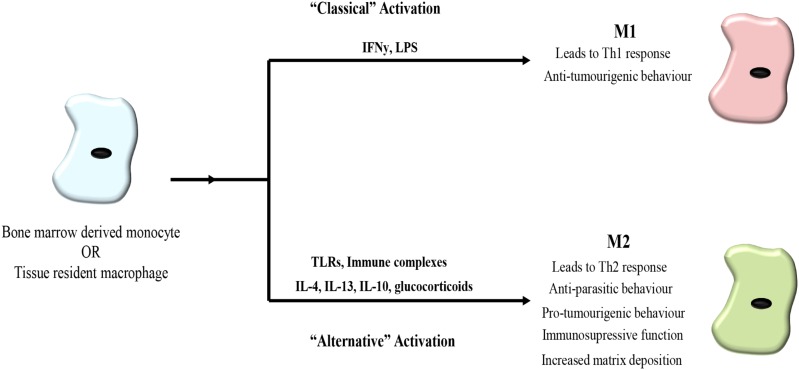
Macrophage polarization. Bone marrow derived monocytes or tissue derived monocytes can be polarized toward either an M1 or M2 phenotype. Classical activation toward M1 polarization occurs in response to interferon gamma (IFNγ) and lipopolysaccharide (LPS) leading to a Th1 response associated with bacteria and viruses as well as possessing anti-tumorigenic properties. Alternative activation toward an M2 phenotype is triggered in response to toll-like receptors (TLRs), immune complexes, IL-4, IL-13, IL-10, and glucocorticoids. M2 macrophages lead to a Th2 response and exhibit anti-parasitic behavior. In cancer, M2-like macrophages promote tumor progression.